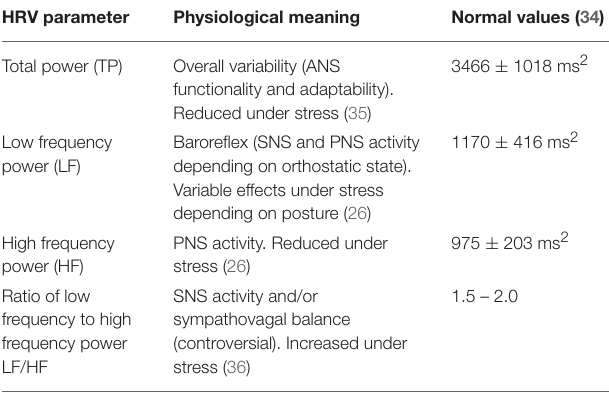
TABLE 1 | Physiological meaning of HRV parameters and their relation to